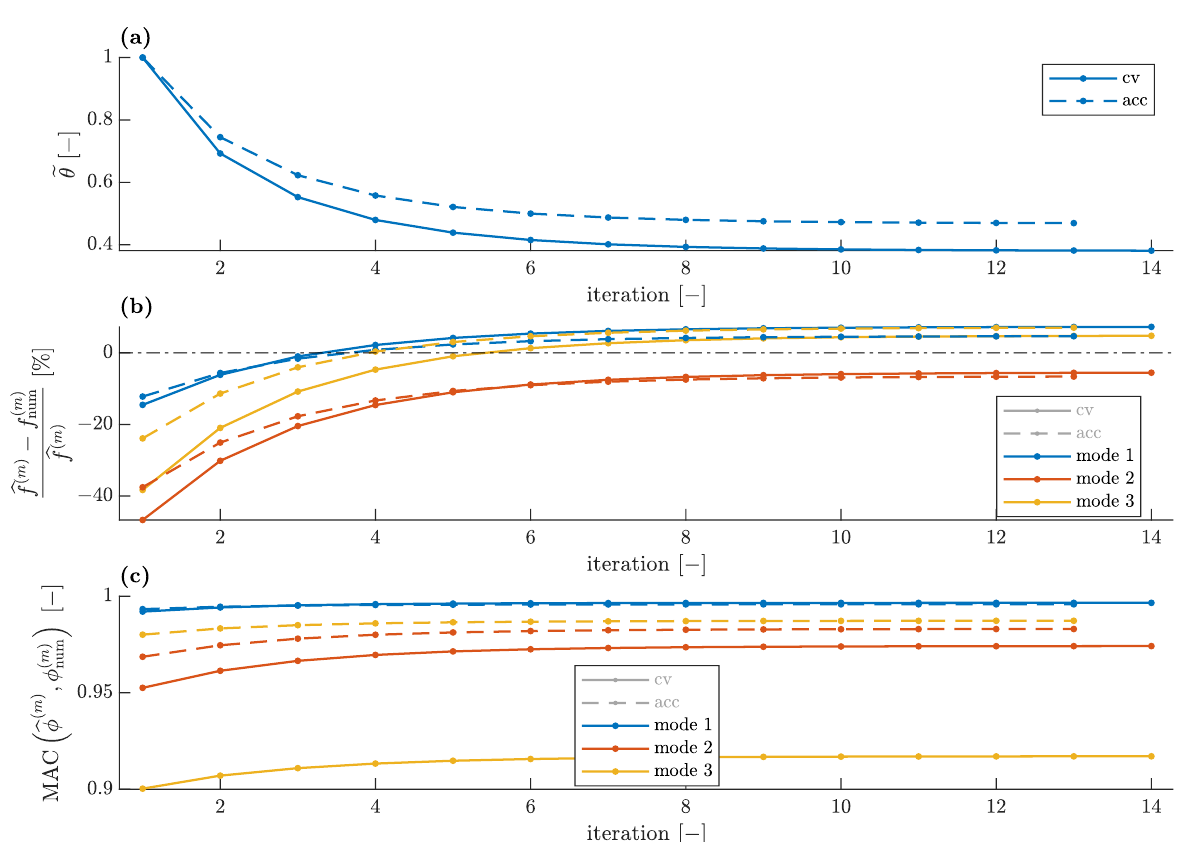
Figure 14. Comparison of convergences of model updating employing accelerometer and CV modal data for single unknown parameter: ( a ) unknown parameter, ( b ) relative natural frequency error and ( c ) modal assurance